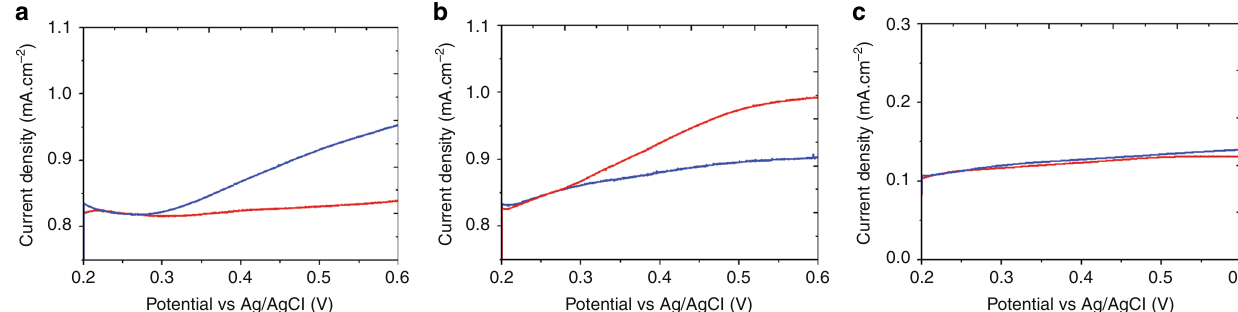
Fig. 3 Electrochemical characterization of enantioselectivity. Differential pulse voltammetry (DPV) in 4 mM (R) -PE (blue), and (S)- PE (red), using 0.2 M KNO 3 as supporting electrolyte with a a CIMP electrode imprinted with (R) -PE, b a CIMP electrode imprinted with (S) -PE, c a non-imprinted mesoporous platinum electrode. All electrodes were prepared using a deposition charge density of 2 C cm − 2 and a PE/PtCl 6 2 − weight ratio of 0.05 for the imprinted